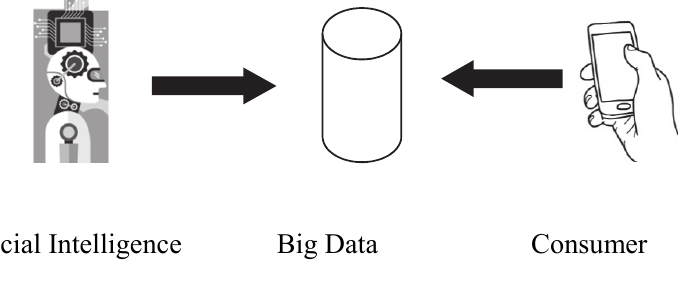
Fig. 1. Big Data in